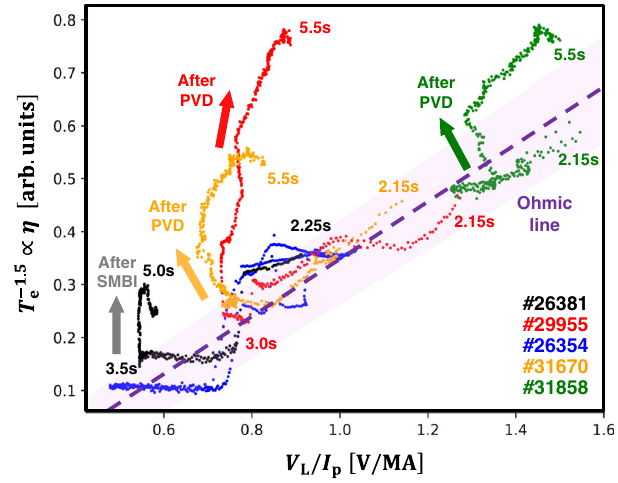
Fig.2|Timetrajectoryof T (cid:2) 1 : 5 e versus V L / I P in#26381,#29955,#26354,#31670, and #31858. The purple-shaded line represents the proportional line.